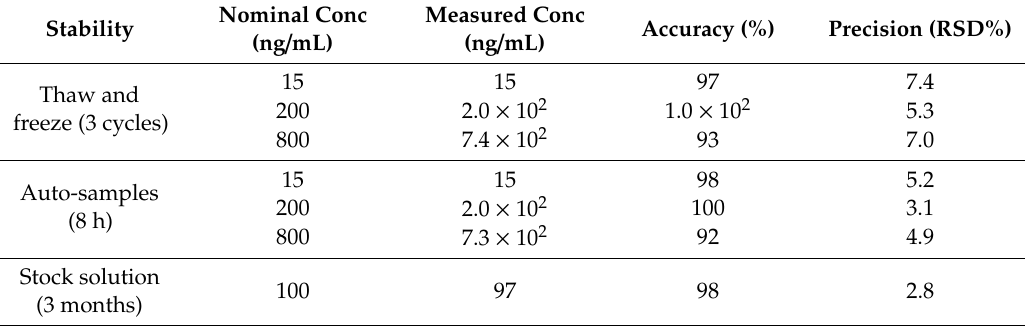
Table 5. Pharmacokinetic parameters of lekethromycin after intravenous administration (5 mg/kg) in rats.